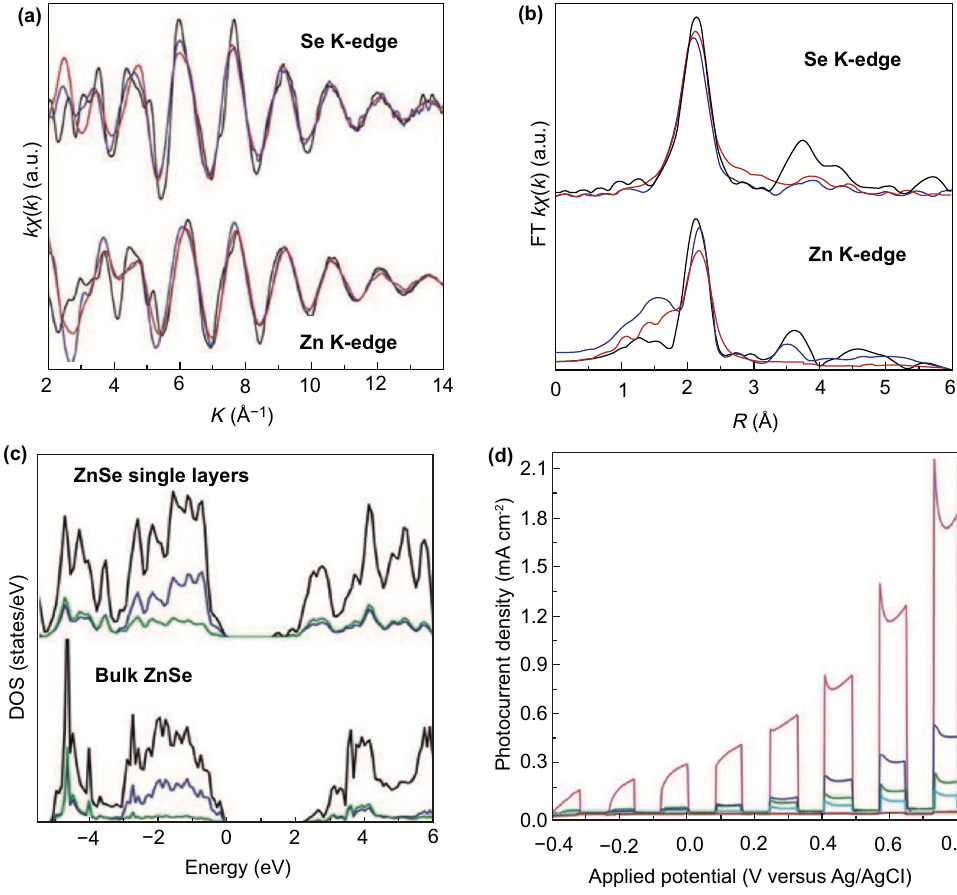
Fig. 17 a Se and Zn K‑edge extended XAFS oscillation function k χ (k). b Equivalent Fourier transforms; red, blue, and black lines show ZnSe SLs, ZnSe‑pa SLs, and bulk ZnSe, in that order. c Simulated DOS; black, blue, and olive lines show total, Se sp, and Zn sp state densities, corre‑ spondingly. d Photo‑current density versus utilized potential curves in chopped 300 W Xe‑lamp irradiation. Adapted with permission from Ref.